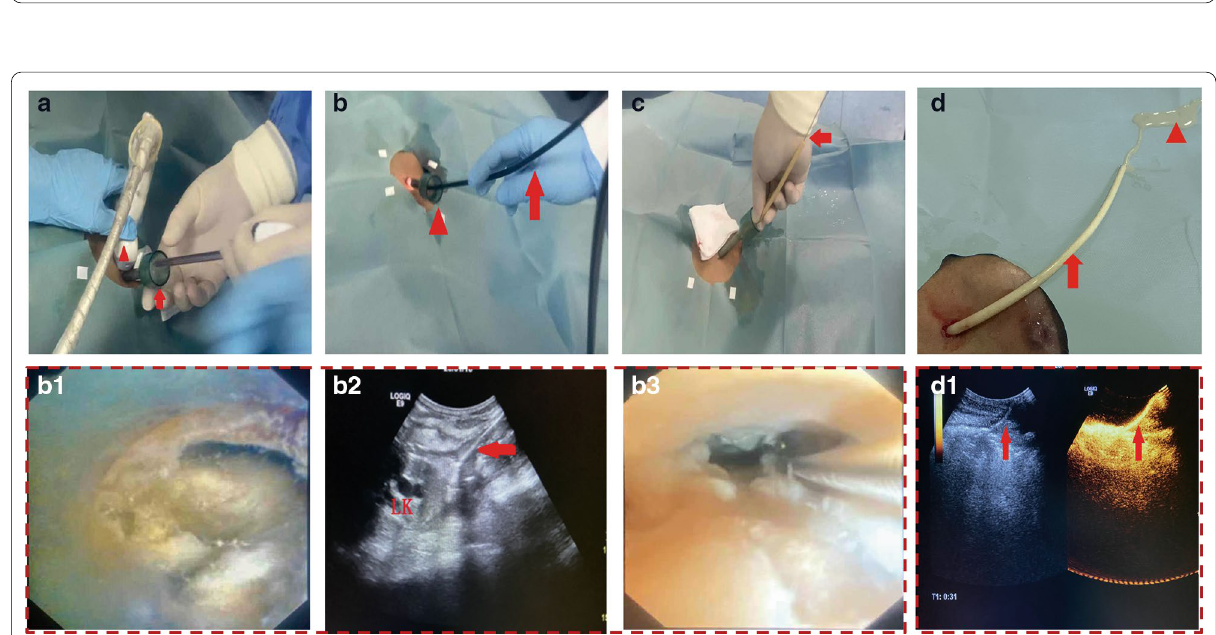
Fig. 3 Images of modified percutaneous catheter drainage under the triple guidance of choledochoscopy, ultrasonography, and computed tomography. a After puncture by the trocar (red arrow), the core is withdrawn to establish a channel for the choledochoscope. b The cholangioscope (red arrow) is introduced through the trocar (red triangle), and the condition of the inner walled‑off necrosis (WON) is observed by the choledochoscope ( b1 ) and ultrasonography ( b2 , red arrow indicates the choledochoscope) in real time, followed by introduction of a guide wire to target the lowest part of the WON ( b3 ). c A multi‑side‑hole catheter (red arrows, 16 Fr) is inserted along the guidewire to fully drain the WON, and abscess accumulation is observed by contrast‑enhanced ultrasonography. d The liquefied necrotic tissue (red triangle) is successfully drained using the catheter (red arrow) and verified by contrast‑enhanced ultrasonography ( d1